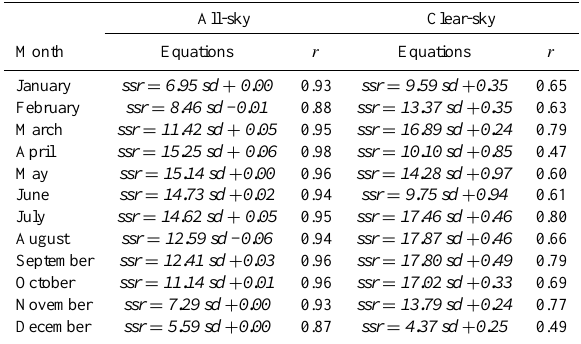
Table 3. Linear regression results for the Swiss mean monthly se- ries, for all-sky and clear-sky SD (in hours) versus SSR (in Wm − 2 ) , over the period 1981–2010.